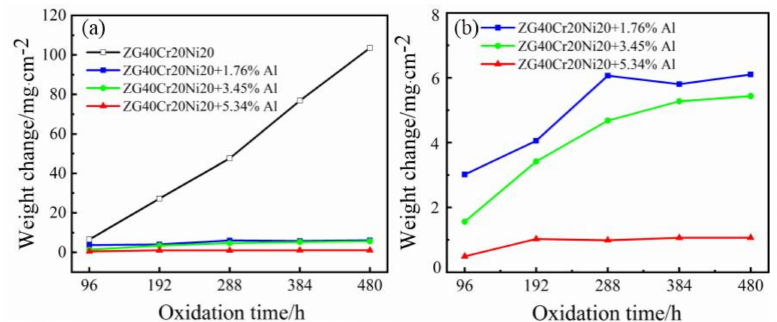
Figure 3. Isothermal oxidation kinetics of ZG40Cr20Ni20Al x steels ( a ) x = 0, 1.76, 3.45, and 5.34, ( b ) x = 1.76, 3.45, and 5.34.